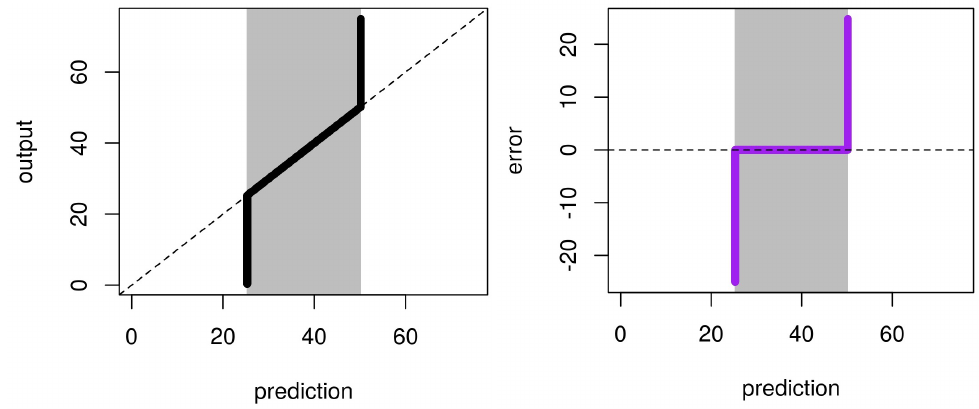
Figure 11. Illustration of the artifact of RFreg on structural modeling error with dataset A and subset type 1. Artfact on the prediction is shown on the left . Artifact on the error is presented on the right . Vertical gray lines represent output subset used for the training